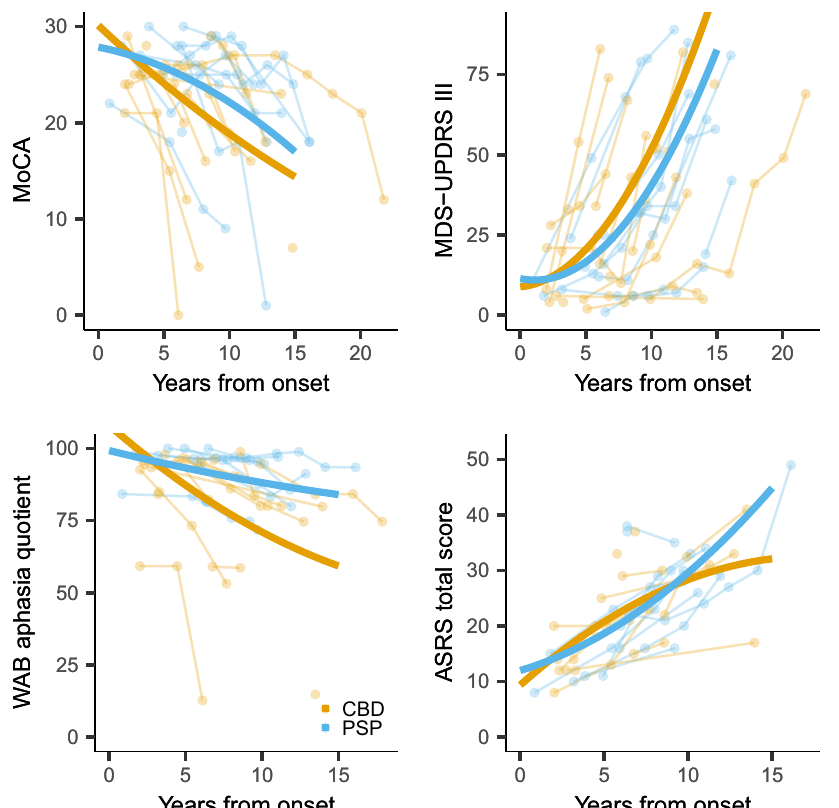
Fig. 2 Trajectories of cognitive decline, development of parkinsonism and global aphasia, and worsening of apraxia of speech over time from disease onset by pathology. Cognitive impairment (top left plot) is measured by the Montreal Cognitive Assessment Battery (MoCA); parkinsonism (top right plot) is measured by the Movement Disorders Society-sponsored revision of the Uni fi ed Parkinson ’ s Disease Rating Scale part III (MDS-UPDRS III); global aphasia severity (bottom left plot) is measured by the Western Aphasia Battery (WAB) Aphasia Quotient; and apraxia of speech (bottom right plot) by the Apraxia of Speech Rating Scale (ASRS). Individual patient trajectories are shown as well as nonlinear trend lines for both PAOS-CBD and PAOS-PSP patients. Source data are provided as a Source Data fi